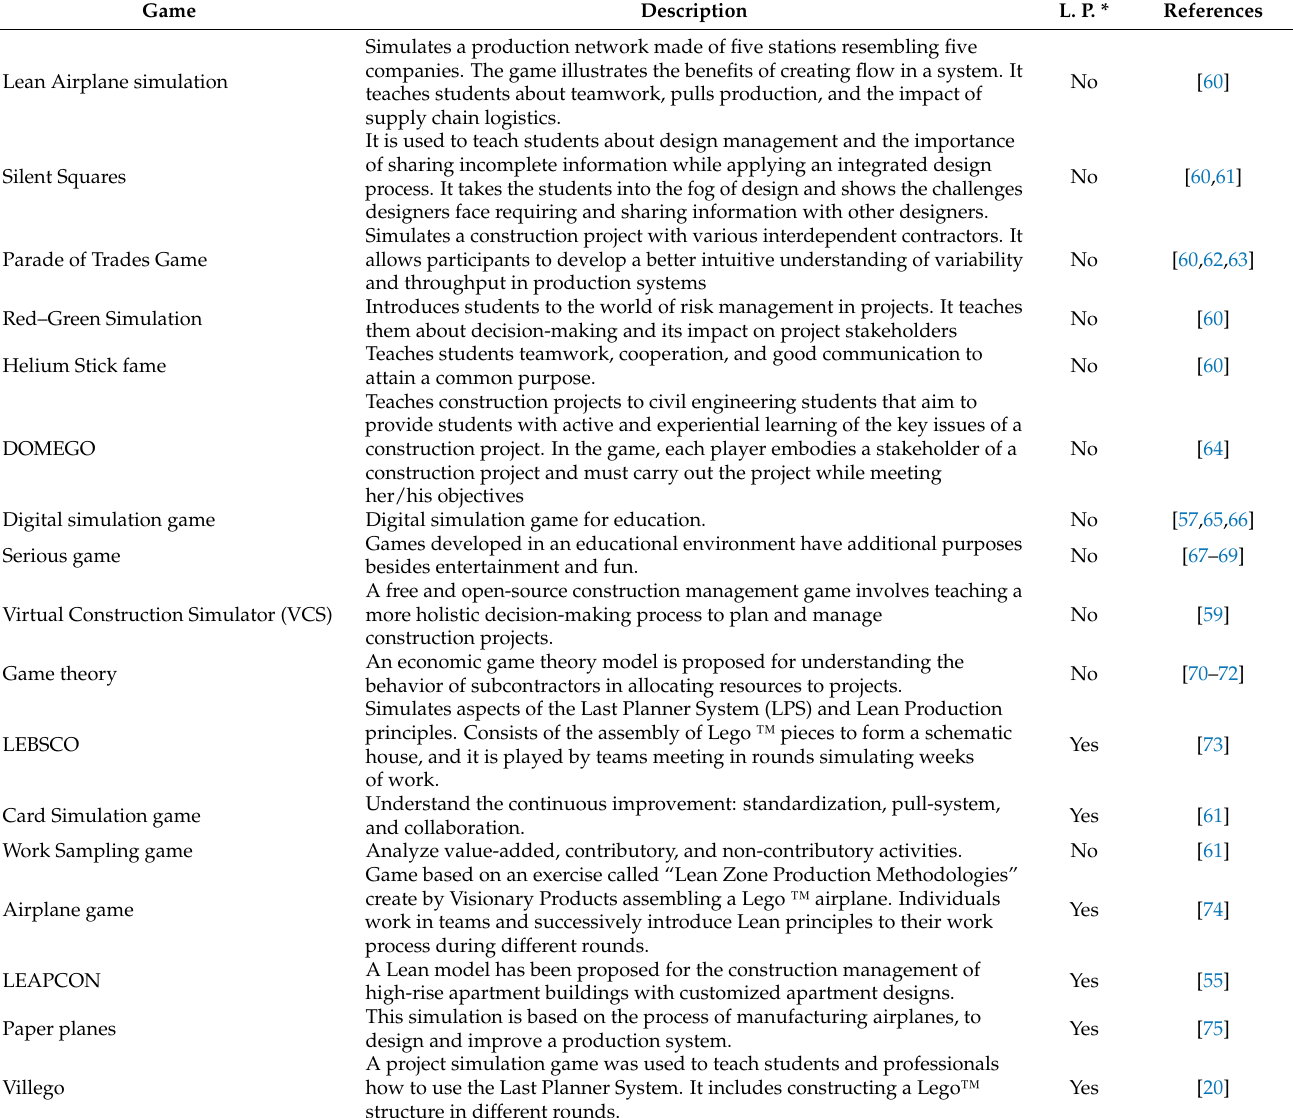
Table 1. Games related to Lean Construction principles implemented in Engineering